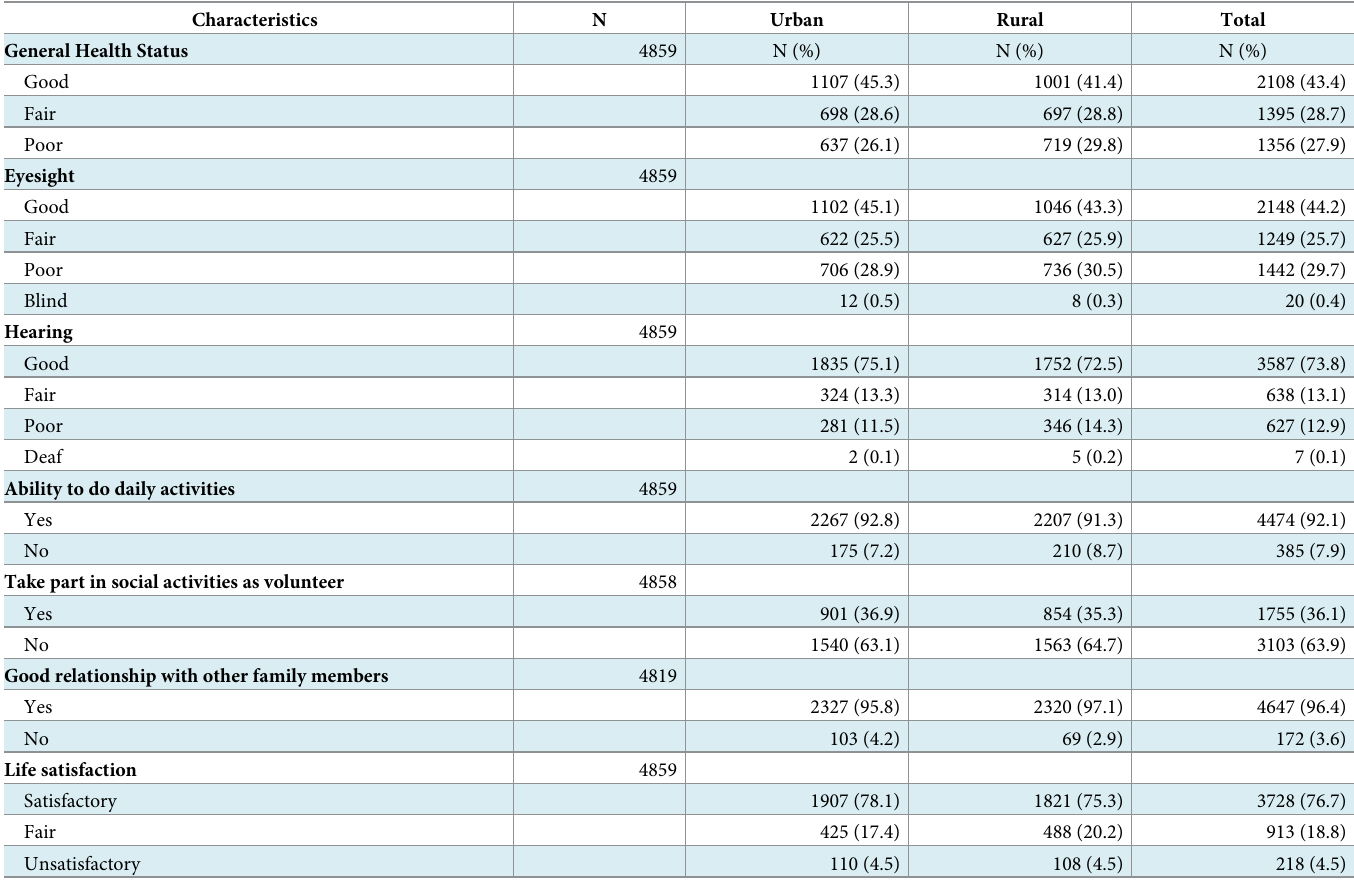
Table 2. General health status, relationship with the family and social involvement of study participants.